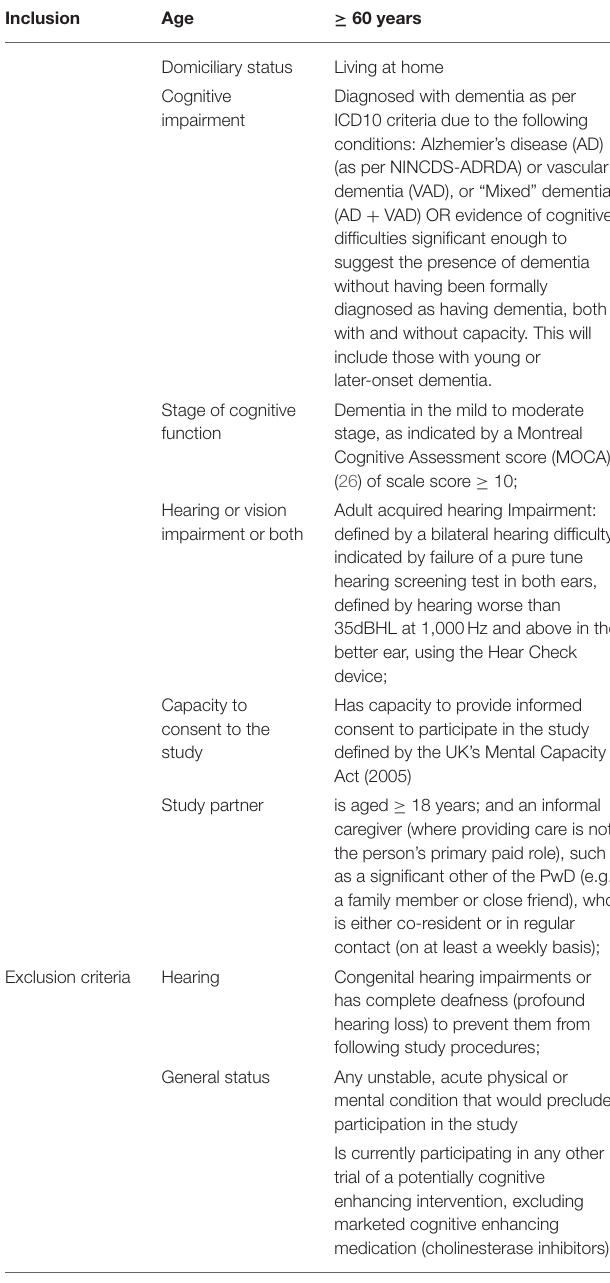
TABLE 3 | Participant demographic and clinical characteristics at baseline ( n = 15